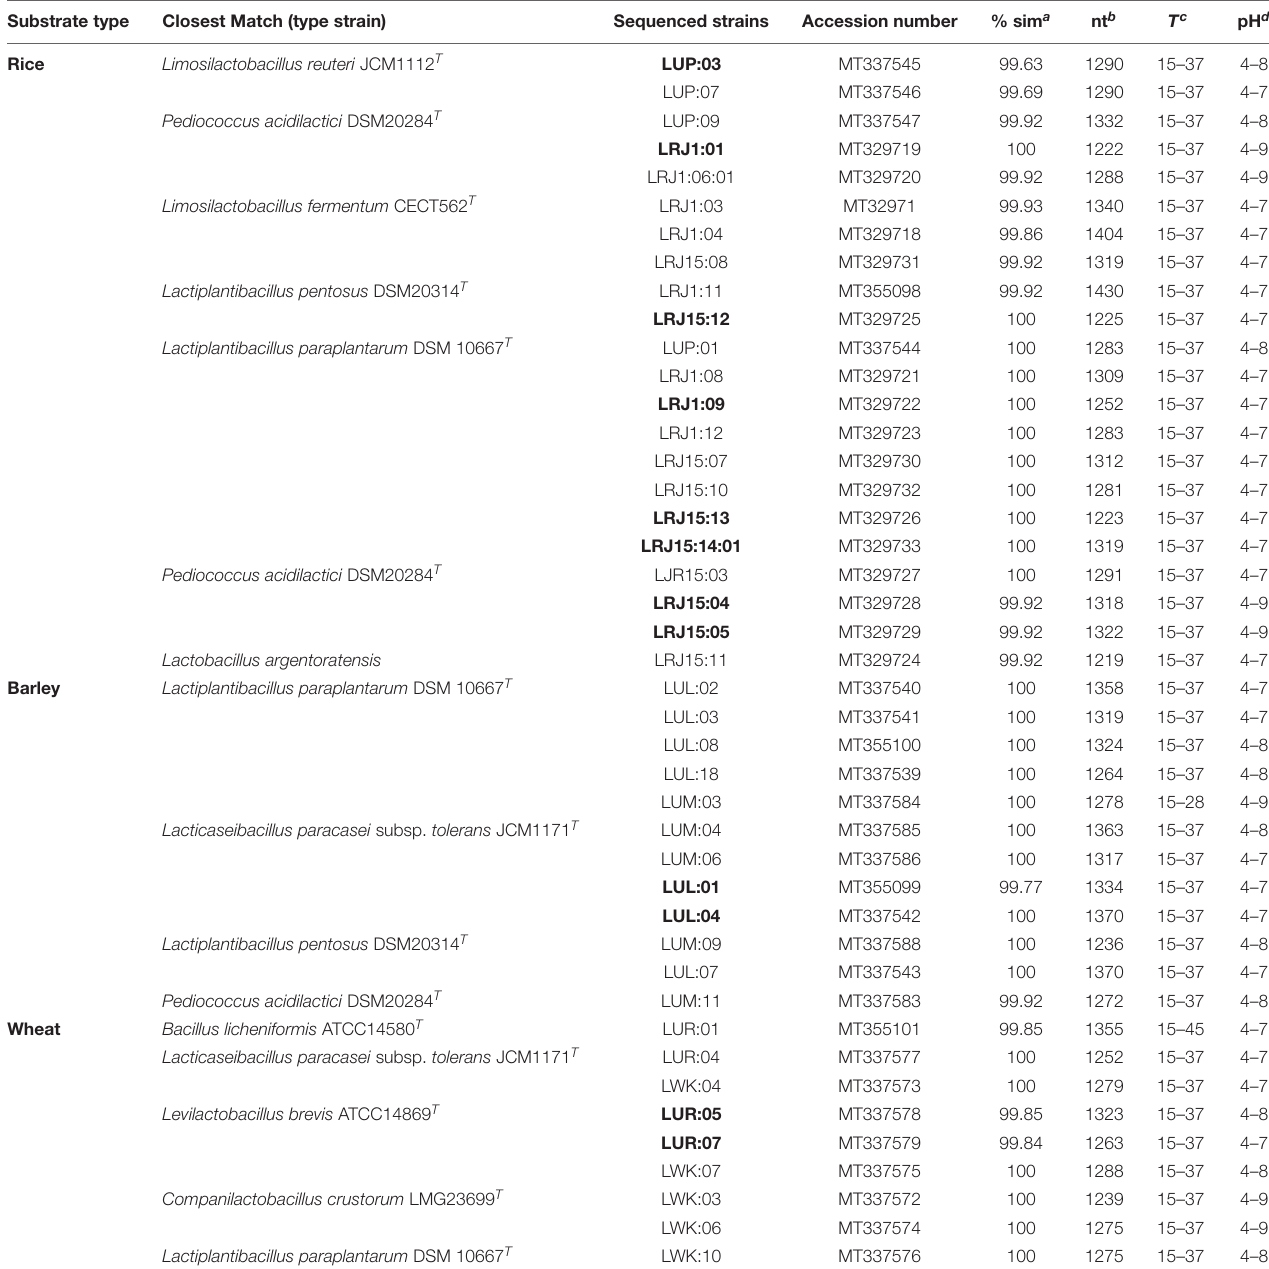
TABLE 2 | Identification of probiotic strains isolated from traditional fermented beverage lugri of North Western Himalaya. Substrate